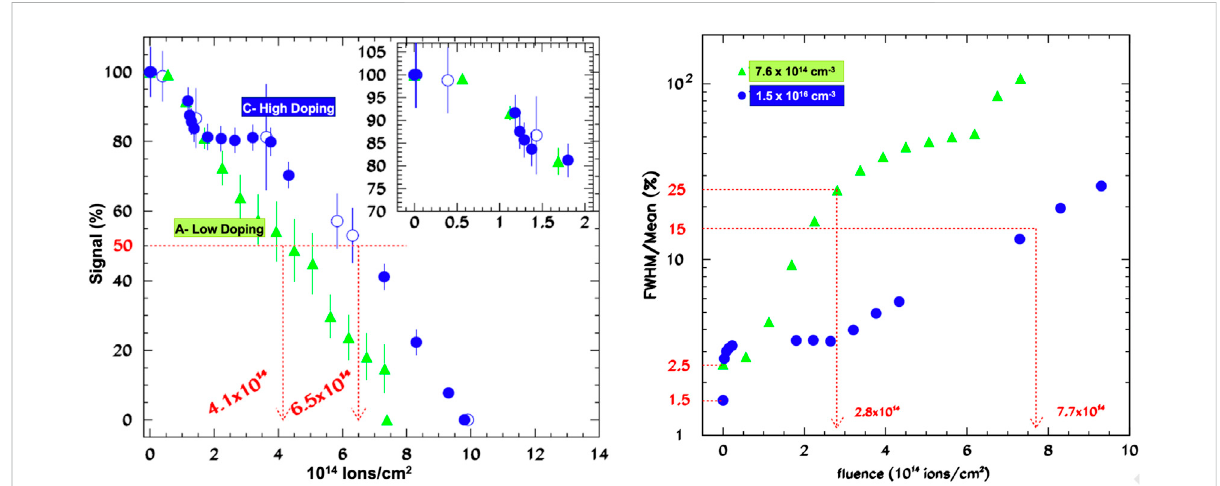
FIGURE 7 Left: Percentage of the signal generated by 16 O ions after irradiation as a function of the ion fl uence. Two SiC detectors with different doping concentrations are compared. SiC have been irradiated with 16 O ions at 32.7 MeV. Right: Variation of the two SiC detectors ’ energy resolution as a function of irradiation fl uence. Data are from Ref.